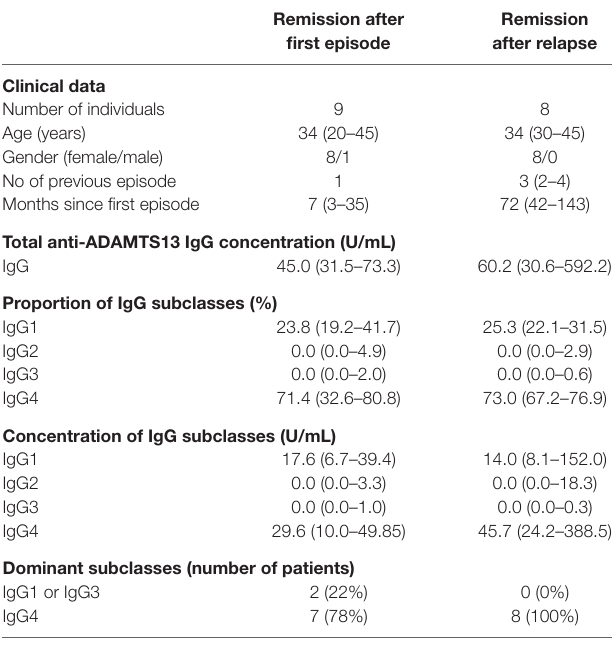
TaBle 2 | Levels and subclass distribution of anti-ADAMTS13 IgG antibodies in clinical remission following the first acute episode and following a